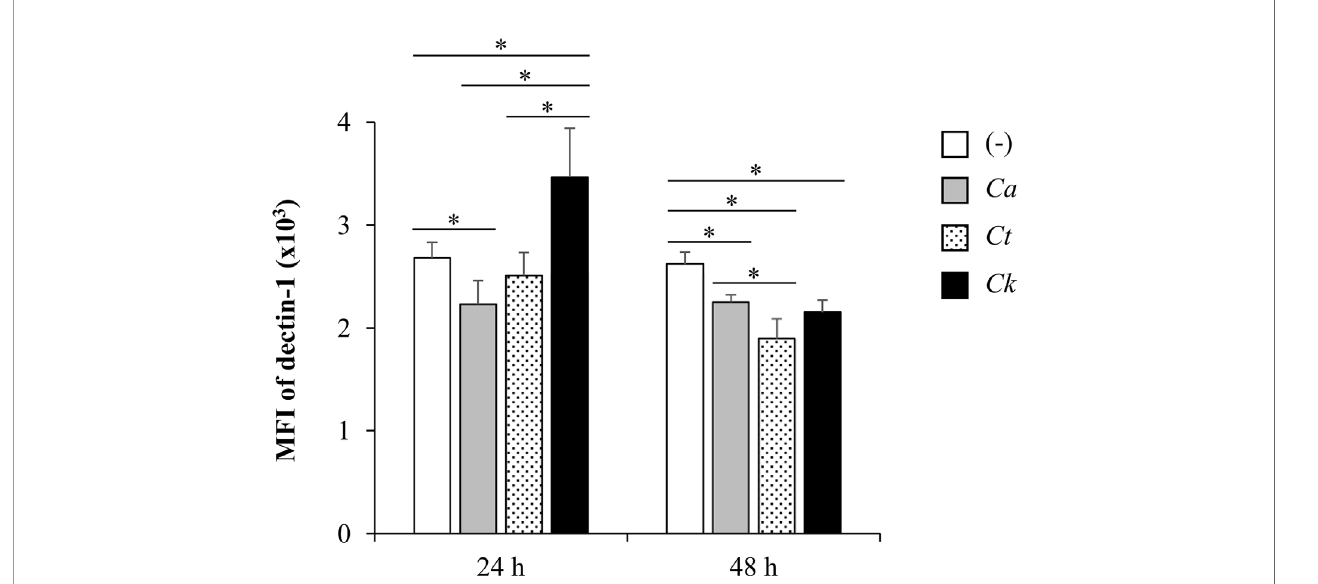
FIGURE 13 | Differential dectin-1 expression on Candida b -glucan-stimulated bone-marrow derived dendritic cells (BMDCs). BMDCs were stimulated with 25 µg/ml of b -glucans isolated from C. albicans , C. tropicalis , and C. krusei for 24 h and 48 h, and the geometric mean fl uorescence intensity (MFI) of dectin-1 on CD11c + cells were determined using histogram analyses. n = 5; data are representative of two independent experiments. * p < 0.05. (-), unstimulated BMDCs; Ca , C. albicans ; Ct , C. tropicalis ; Ck , C. krusei